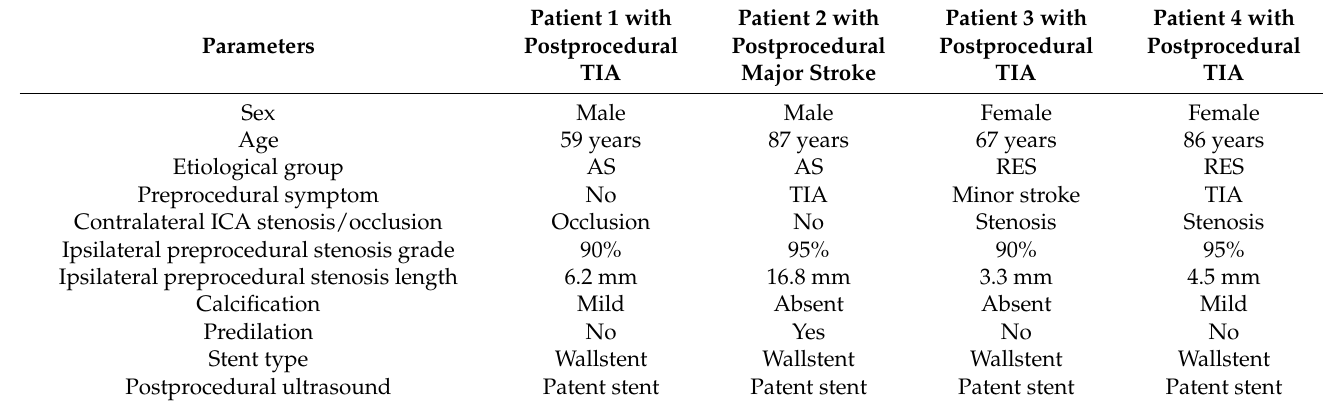
Table 4. Parameters of patients with postprocedural neurological